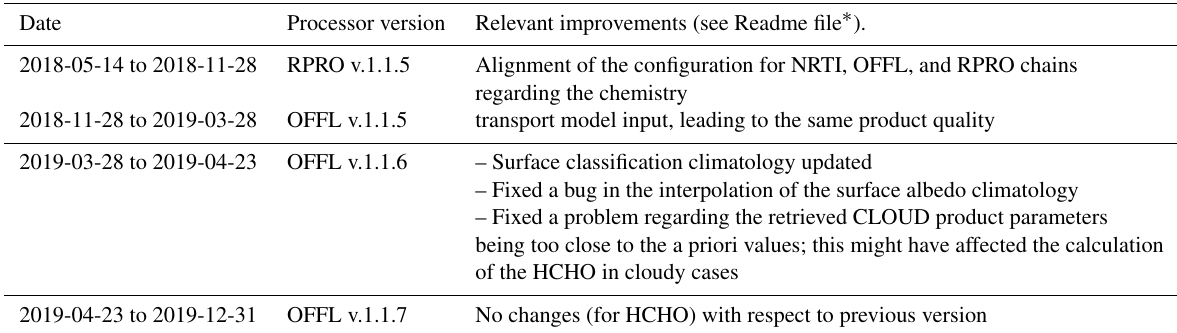
Table 1. TROPOMI RPRO+OFFL complete time series versions 1.1.(5-7) used in the present work.